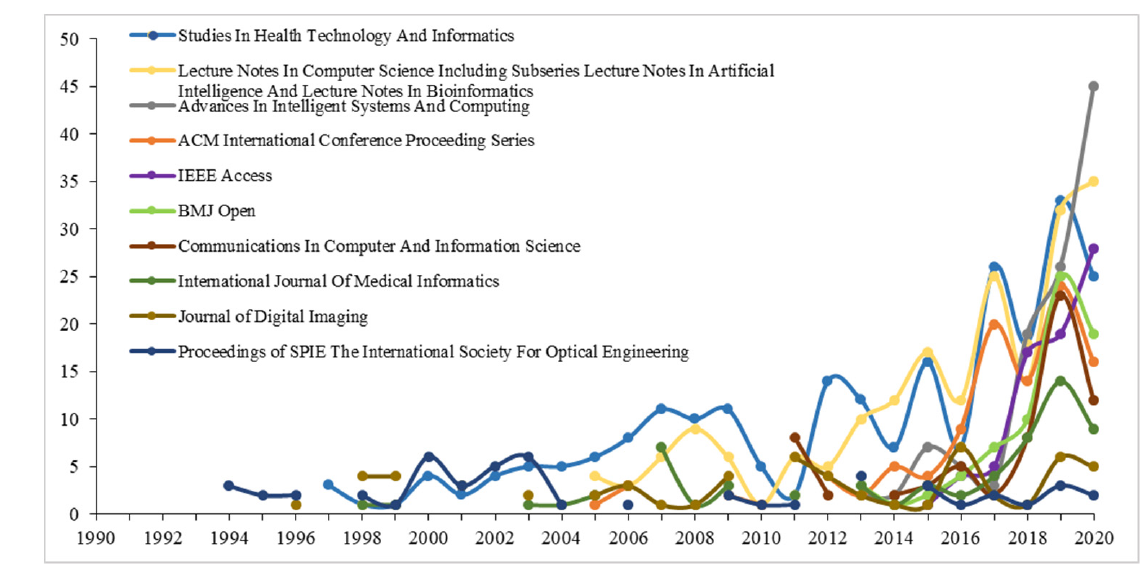
Figure 7. Publications about digital healthcare of top 10 source journals 1990-2020. Table 3. Top ten source publications by number of documents.